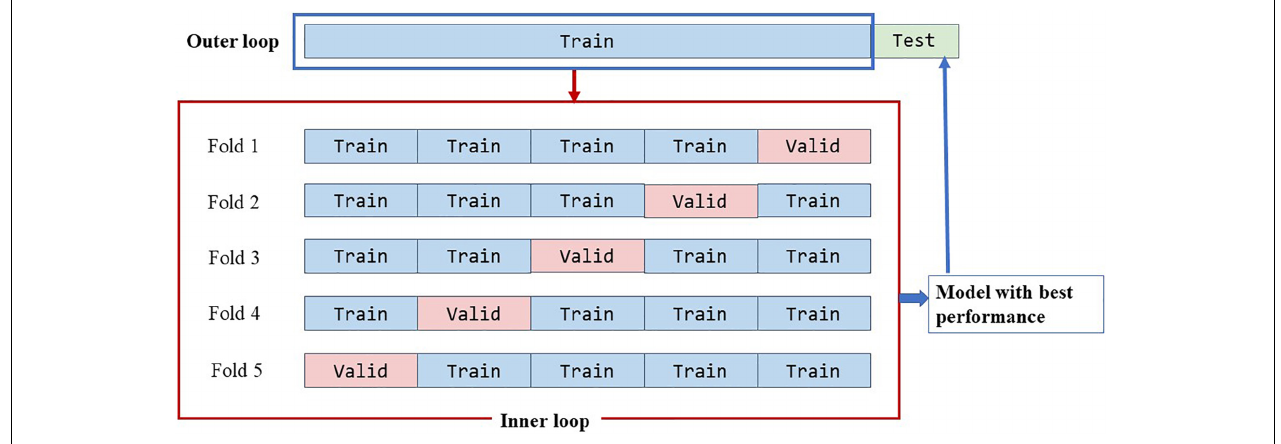
FIGURE 5 | Data spilt strategies. TABLE 2 | Performance of different ResNet using two-stage model.